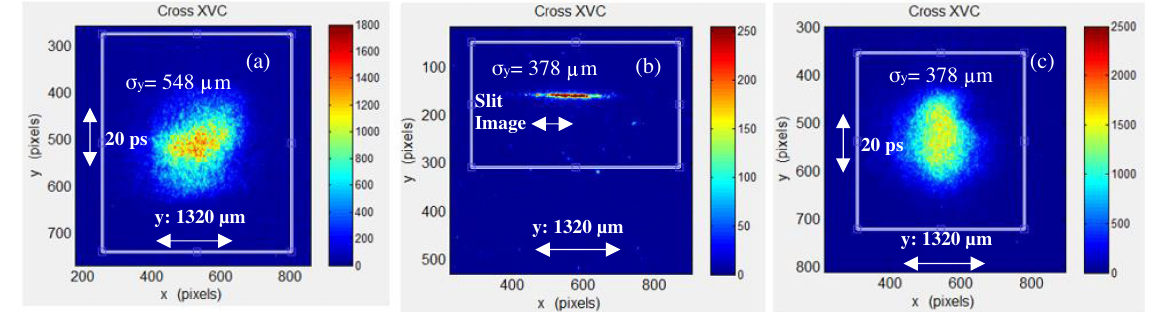
FIG. 4. (a) OTR streak-camera y-t image at X121 with HOMs as found for run 1. (b) OTR focus mode image for the corrected steering, and (c) OTR streak-camera y-t image at X121 that exhibits an elliptical-shape effect with HOMs minimized using the H/V101 and H/V103 correctors. These streak-camera data are ten-image averages. The projected y sizes are shown for all three images with the as-found case 40% larger than (c). The spatial and temporal scales are provided by the arrow heads. Pseudocolor intensities are shown in the vertical bars at the right of each